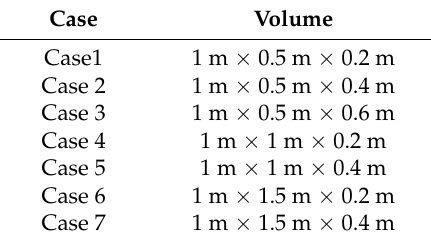
Table 3. Schedule of the model